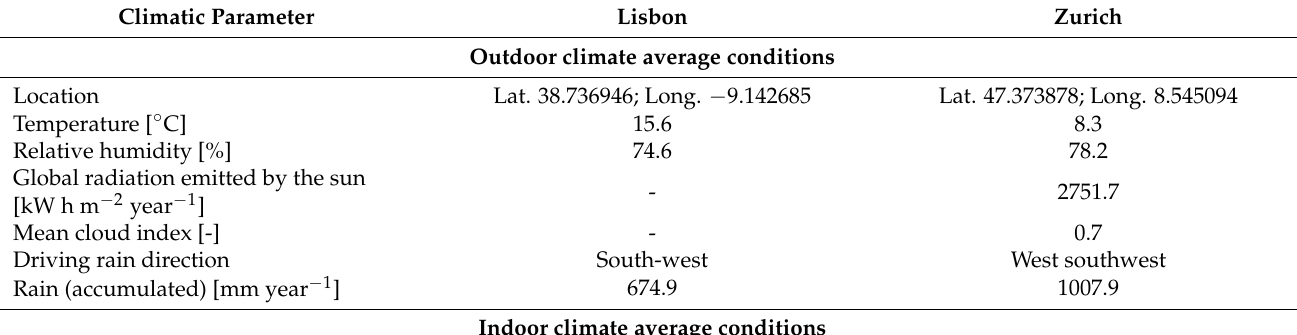
Table 5. Outdoor and indoor average climatic conditions are available in the WUFI